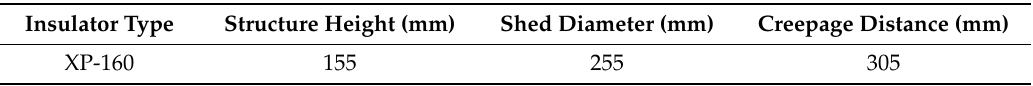
Table 1. Structural parameters of the